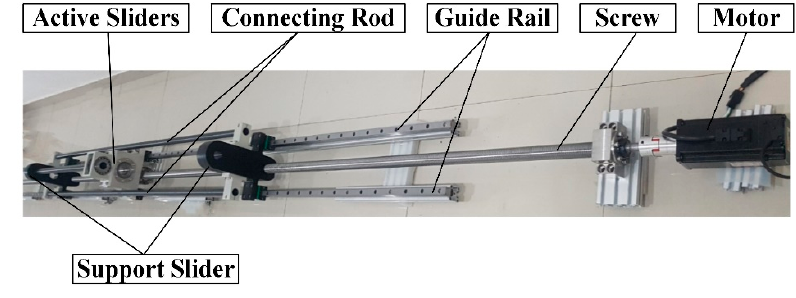
Figure 7. The experimental model.